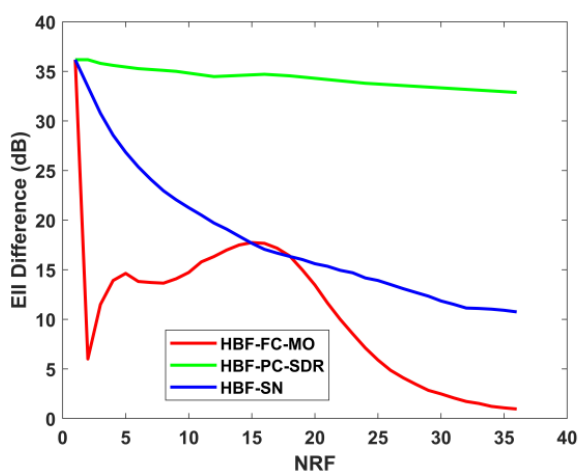
Figure 8. EII of three categories of simplified structures and FD-ALSTAR under different NRF conditions.